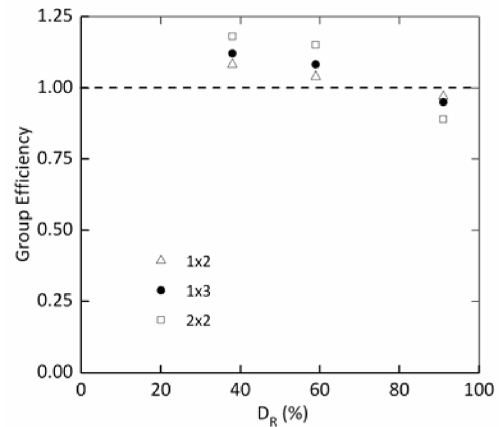
Fig. 8. Load-capacity group efficiency of driven pile groups